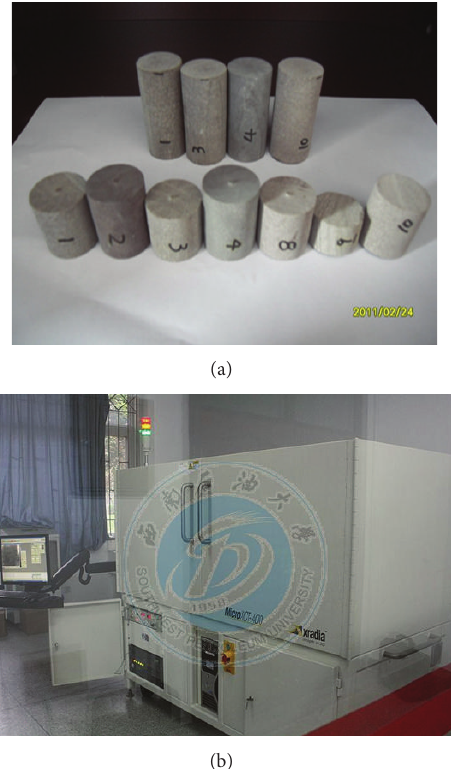
Figure 1: Sandstone samples and equipment used in this research. (a) is initial sandstone samples; (b) is Micro X CT-400.